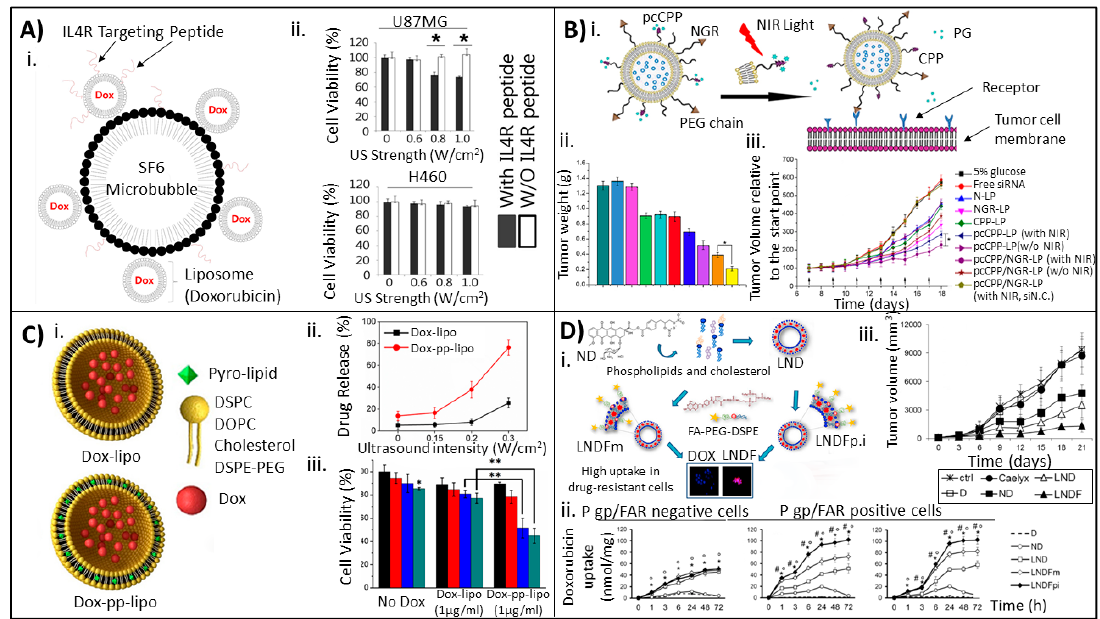
Figure 6. Liposomal bioconjugation strategies utilizing peptides and other small molecules for improved drug delivery and targeting. ( A ) ( i ) Schematic of MB-liposome (Dox) IL4RTP. ( ii ) Demonstrated inhibition of IL4R-expressing cell proliferation (U87MG) when treated with MB-lipo (Dox) at varying strengths of ultrasound with or without IL4R peptide attached. Comparison is shown to H460 (IL4R expression low) is shown, demonstrating the MB-lipo (Dox) IL4RTP primarily affects cells when ultrasound strength > 0.8 W / cm 2 and cells are IL4R-expressing. Cell viability was determined via the WST-1 assay (* p < 0.001). Image adapted from Park © Spandidos Publications (2016) Ref. [112]. ( B ) ( i ) Schematic of depicting the siRNA-carrying pcCPP / NRG-LPs. The dual-modified liposomes are targeted to the tumor via the NGR ligand and upon activation with NIR light once at the tumor site, the photosensitive group (PG) is released, activating the CPP and allowing liposome entry into the cell. ( ii ) Weight of xenograft tumors after 10 days treatment (treatment began once tumors grew to approximately 50 mm 3 ). Legend: teal; 5% glucose, blue, Free siRNA; magenta, pcCPP / NGR-LP (withNIR,siN.C.); green, N-LP;turquoise, pcCPP-LP(withoutNIR);red, CPP-LP;cobalt, pcCPP / NGR-LP (without NIR); purple, NGR-LP; orange, pcCPP-LP (with NIR); yellow, pcCPP / NGR-LP (with NIR). (* p < 0.05). ( iii ) Tumor volume relative to volume at the start point of treatment over days (* p < 0.05). ( iii ) Image from Yang © Elsevier (2015) Ref. [105]. ( C ) ( i ) Diagram of Dox-lipo versus Dox-pp-lipo (liposomes containing porphyrin within the membrane) for sonodynamic therapy. ( ii ) Dox release profile of Dox-lipo versus Dox-pp-lipo under increasing ultrasound intensities. Legend: black, no ultrasound; red, 0.15 W / cm 2 , blue, 0.2 W / cm 2 , teal, 0.3 W / cm 2 . ( iii ) Cell viability of U87 cancer cells after incubation with unloaded liposomes, Dox-lipo, or Dox-pp lipo under creasing ultrasound intensities. Cell viability was determined 24 h after treatment exposure using a CCK-8 assay (** p < 0.01). Image adapted from Wang © Elsevier (2018) Ref. [84]. ( D ) ( i ) Schematic of LNDFm and LNDFp.i formulation, relying on folic acid receptor-dependent uptake for delivery of doxorubicin in P-glycoprotein-positive cancer cells. ( ii ) Uptake of doxorubicin in P gp / FAR negative cells, MDA-MB-231 (drug resistant) cells, and TUBO cells over 72 h while incubated with different treatment types, including LNDFm and LNDFpi ( ◦ p < 0.01, * p / # p < 0.001). ( iii ) TUBO xenograft tumor growth in treated with control (ctrl), Dox (D), Caelyx, nitroxy-doxorubicin (ND), liposomal ND (LND), and LNDF, as measured by calipers. (ND / LND / LNDF vs. Ctrl group: * p < 0.01; ND / LND / LNDF vs. D: ◦ p < 0.01; LNDF vs. ND: # p < 0.001; LNDF vs. LND: p < 0.05.) Image from Gazzano © Elsevier (2018) Ref. [69] .